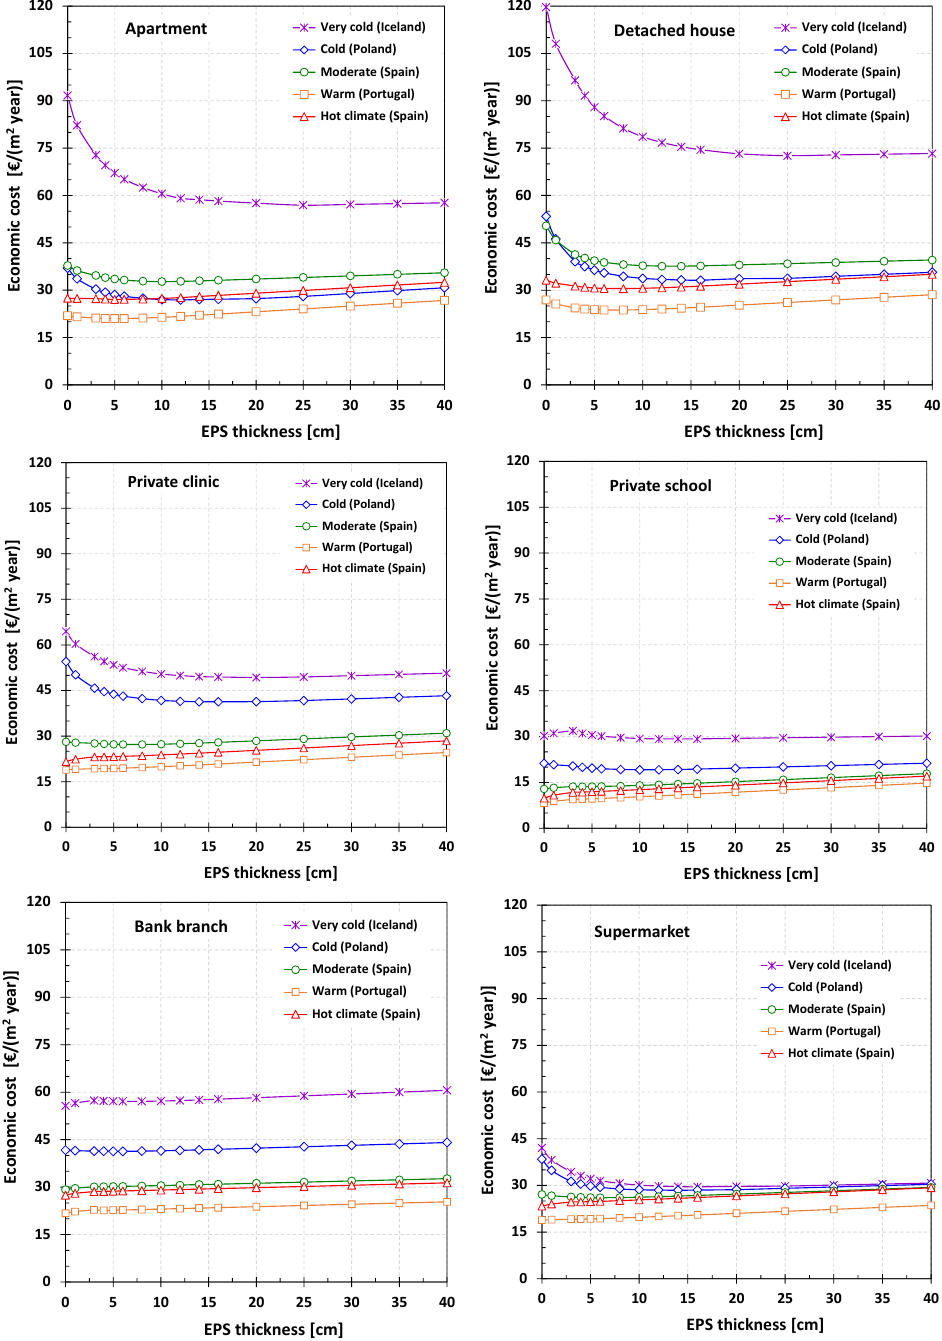
Figure 6. Economic equivalent annual cost per unit area to maintain thermal comfort conditions.